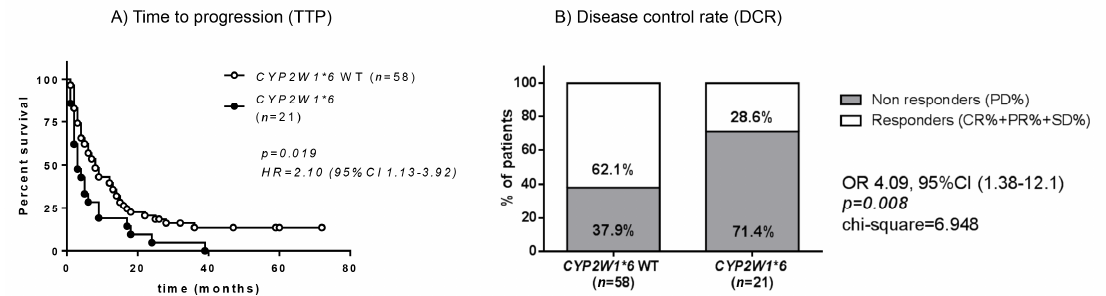
Figure 3. CYP2W1*6 SNP and response to mitotane therapy in group B ( n = 79). ( A ) Time to progression under therapy (TTP) in patients with CYP2W1*6 compared to those having the wild-type (WT) allele (median TTP 3 vs. 8 months). Statistical analysis by Kaplan-Meier survival curves and Log Rank (Mantel-Cox) test. ( B ) Disease control rate (DCR) according to RECIST 1.1 criteria [28]. DCR was defined as the proportion of patients whose best response was complete response (CR) or partial response (PR) or stable disease (SD) according to RECIST 1.1 criteria. Statistical analysis for DCR was performed by Chi-square test on absolute